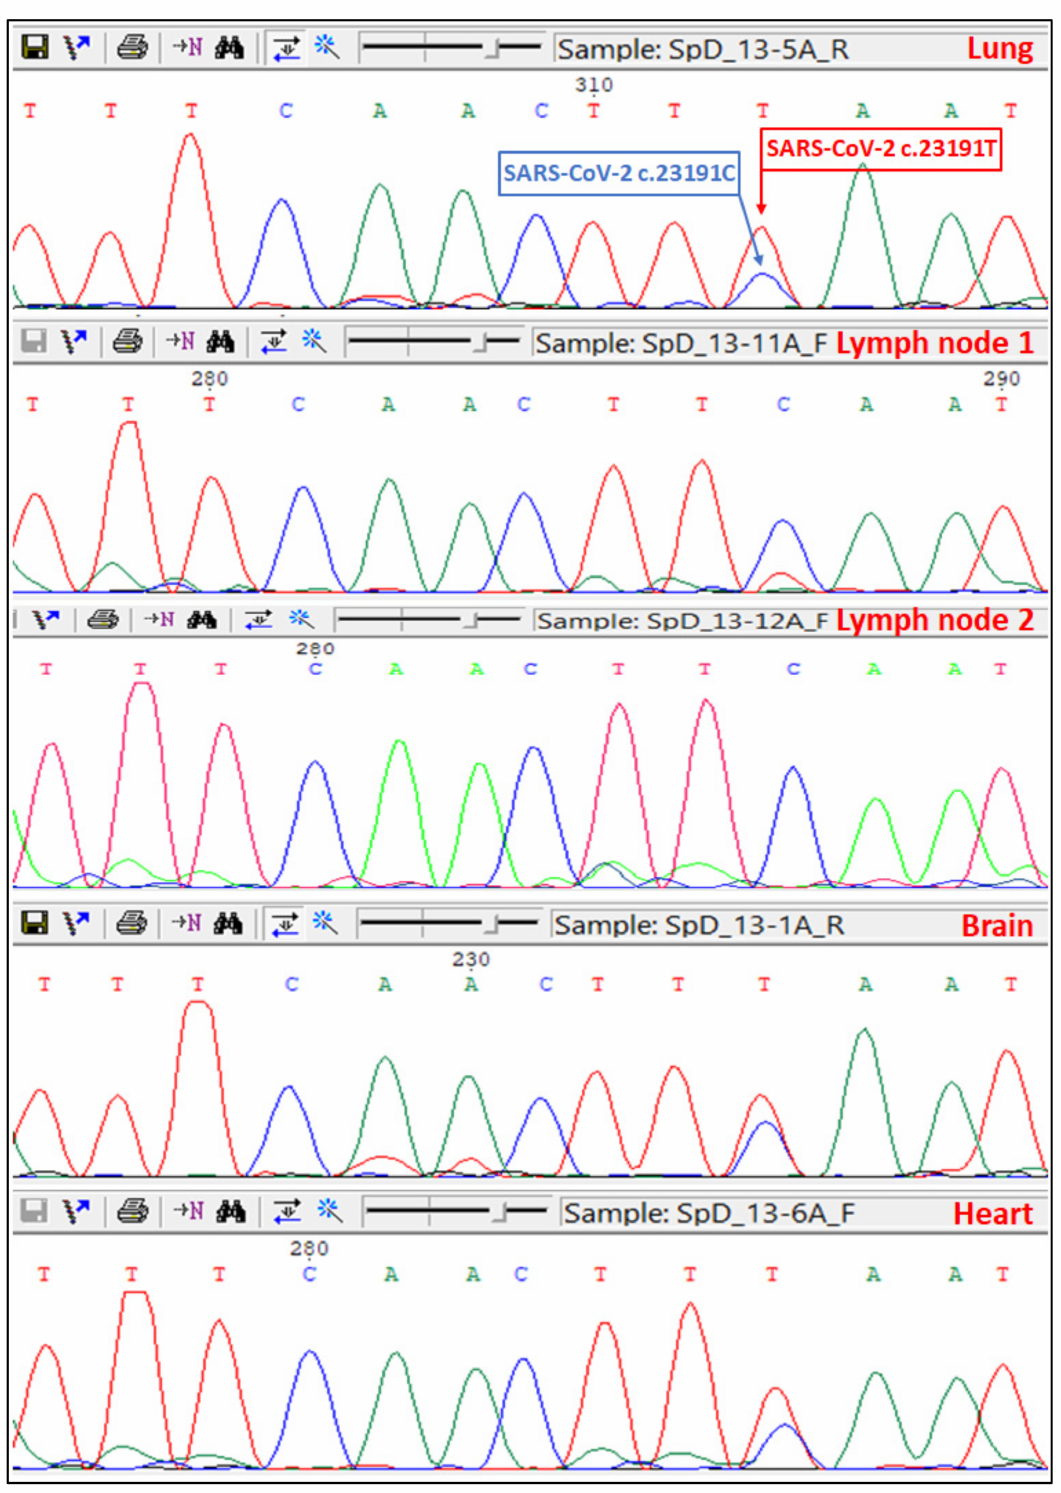
Figure 3. Spike gene Sanger sequencing chromatograms of lungs, lymph nodes, brain, and heart tissues of Patient